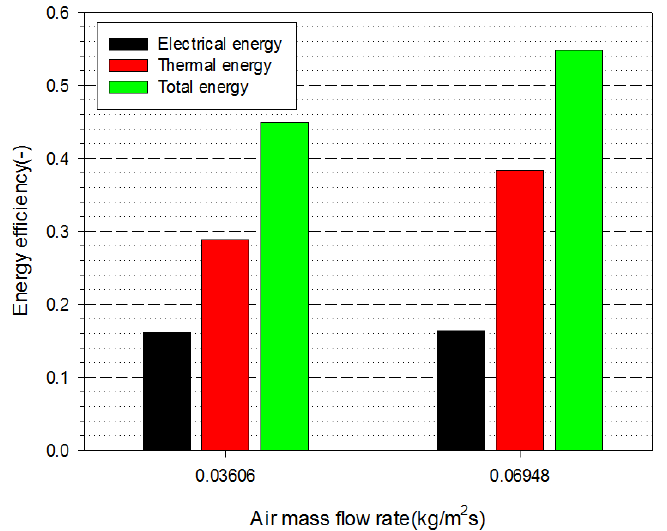
Figure 11. Average values of energy efficiency during the test period.